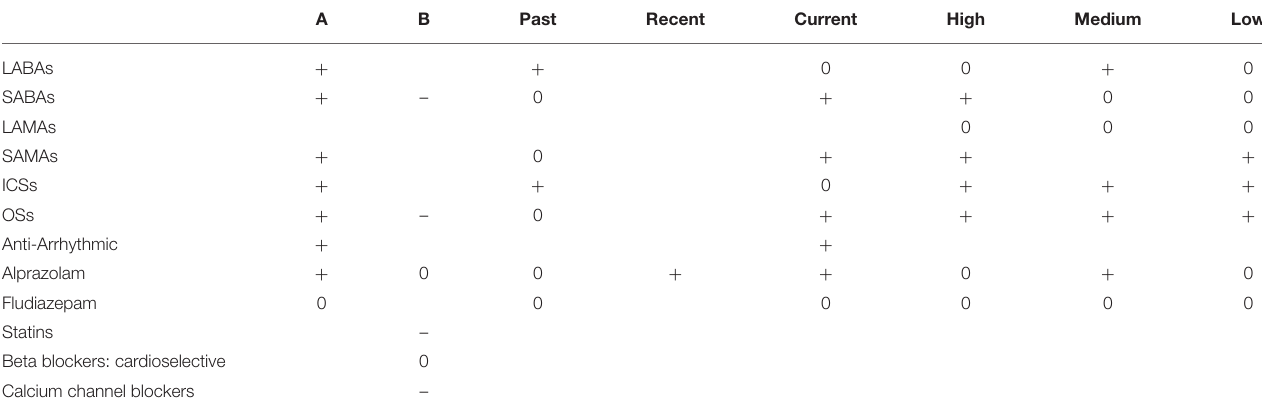
TABLE 6 | Summary findings of